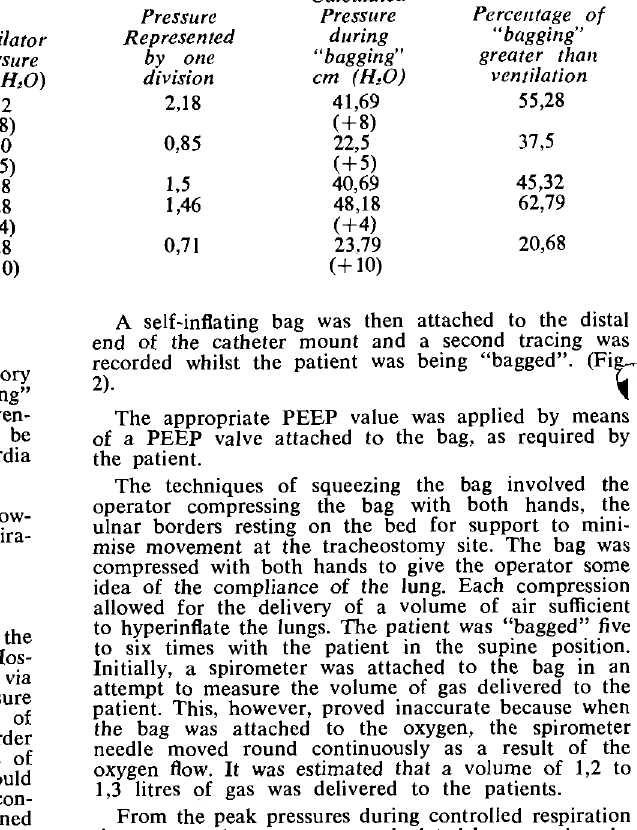
TABLE 1. Numerical data calculated from graphs. Pressures in brackets represent PEEP values for those patients.